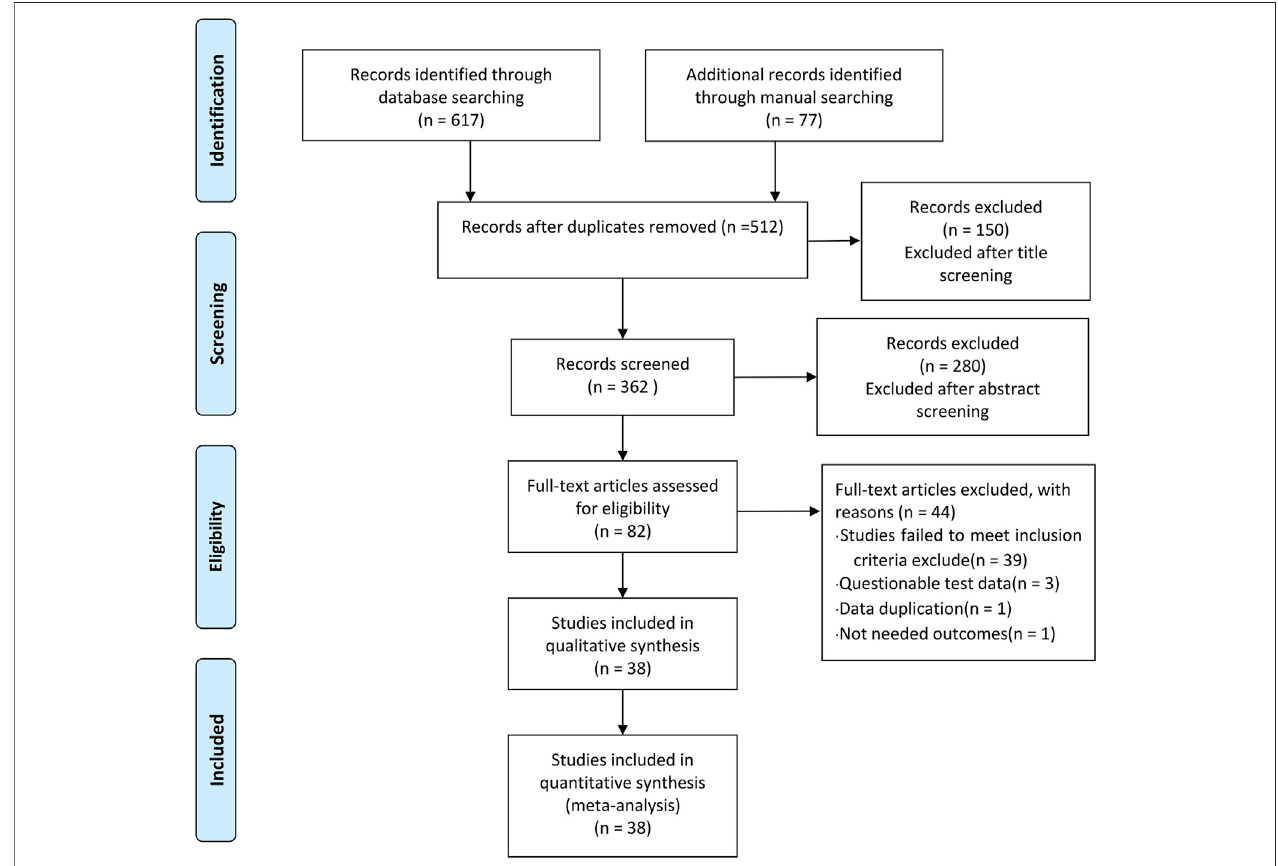
FIGURE 1 | Study fl ow